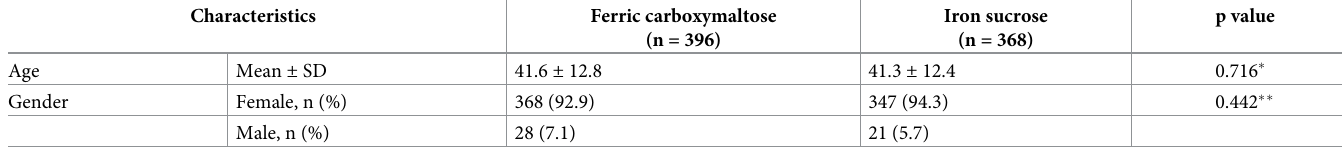
Table 1. Demographic profiles of patients in the two treatment arms.